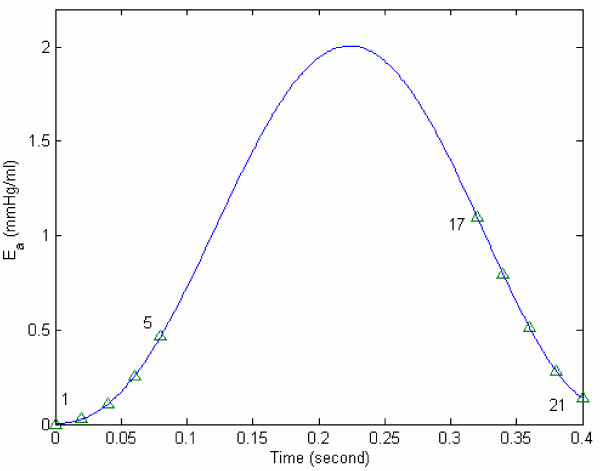
Ea vs. time for the data of figure 2. Points (1–5) are the computed values of Ea during isovolumic contraction phase, based on equations 11(a-e). In the isovolumic relaxation phase, the computed values are represented by the symbol Δ, for Ea,17 = 1.1 mmHg/ml. The best fit for Ea during isovolumic contraction and relaxation phase is given by the curve: Ea = -12000t6 + 17000t5 - 7700t4 + 1100t3 + 19t2 + 0.59t + 0.00056